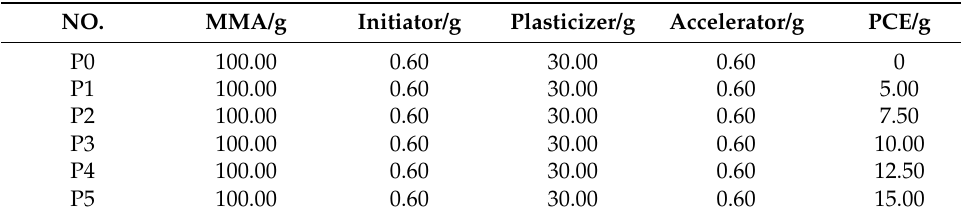
Table 2. Raw materials ratio. MMA: Methyl methacrylate. PCE: perchloroethylene.